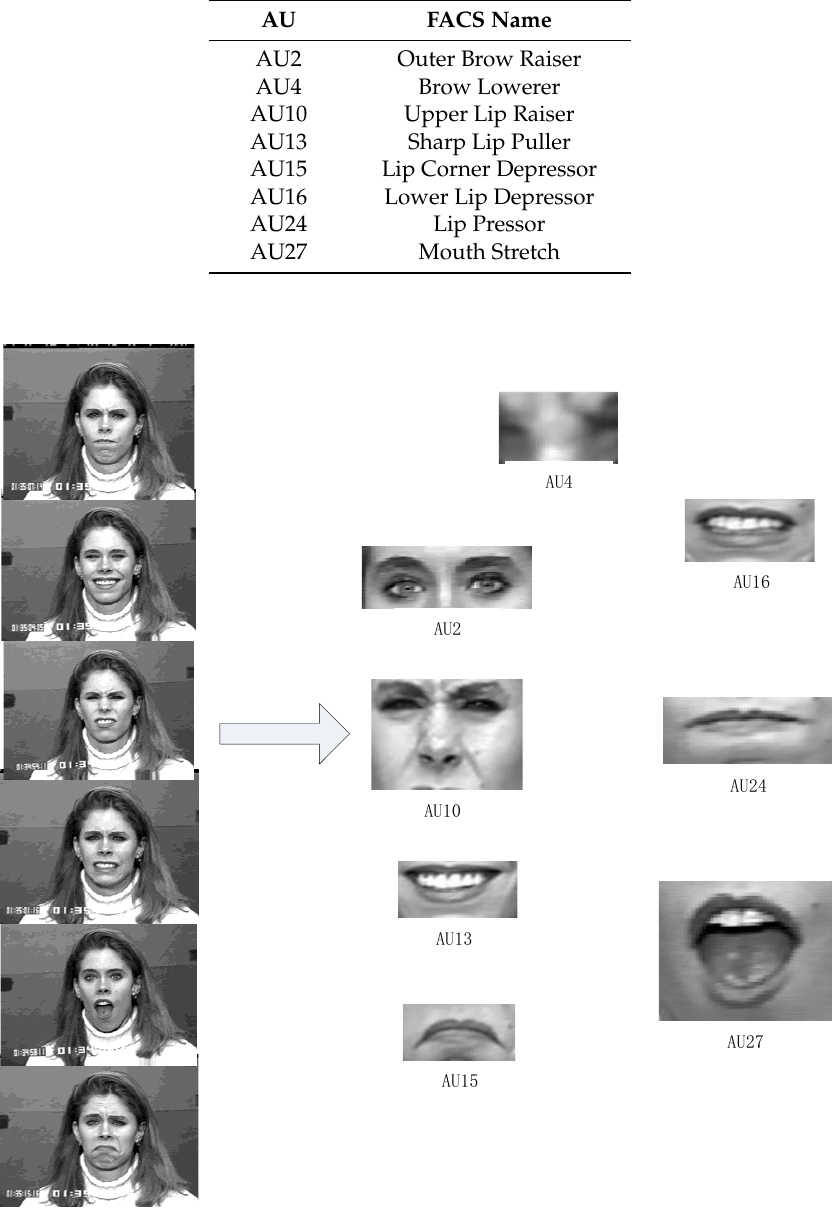
Figure 3. AU blocks from six basic facial expressions.